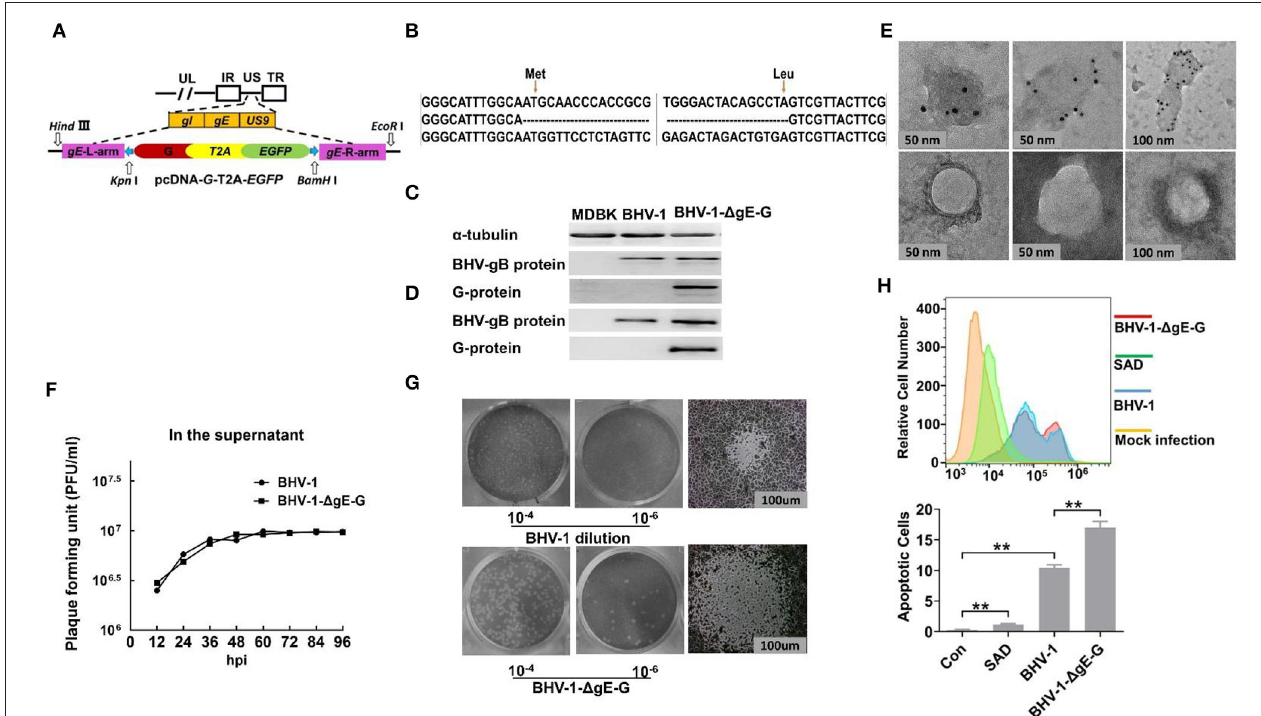
FIGURE 1 | Construction and characterization of BHV-1- 1 gE-G. (A) Schematic on the generation of a recombinant viral vector. The pcDNA3.1 expression vector is used as a backbone to construct the donor template. gE homologous arms were amplified using PCR from BHV-1 with the primer pairs L-ge and R-ge, the RABV G gene was amplified using PCR from SAD with primer pairs G-F and G-R, and the T2A and EGFP genes were amplified using PCR from pCAG-EGFP with primer pairs T2A-EGFP-F and T2A-EGFP-R. These PCR products were digested with enzyme sets HindIII & EcoR I, Kpn I & Not I, and Not I & BamH I, and then ligated into pcDNA3.1 plasmid vector (pcDNA-LgE-G-EGFP-RgE), respectively. (B) Viral genome DNA isolated from BHV-1- 1 gE-G infected MDBK cells was used to carry out PCR and sequencing. (C) The RABV G expressed in MDBK infected with BHV-1- 1 gE-G at 24 hpi was detected by Western blot. (D) The RABV G incorporated in virion of BHV-1- 1 gE-G was purified by sucrose gradient ultracentrifuge and detected by Western blot. (E) The RABV G incorporated in virion of BHV-1- 1 gE-G was purified by sucrose gradient ultracentrifuge and analyzed by EM. (F) Multistep growth curves of BHV-1- 1 gE-G and BHV-1 in MDBK cells. MDBK cells were infected with the indicated viruses at an MOI of 0.01, and the virus titers in infected cell supernatants were determined at indicated time point. (G) The plaque diameter of BHV-1- 1 gE-G and BHV-1 was analyzed by the viral plaque assay using a Nikon ECLIPSE TS100 microscope. (H) The prorogation of apoptotic cells infected by BHV-1- 1 gE-G, BHV-1, and RABV was determined with BD Accuri C6 Flow Cytometer, and the data were analyzed with FlowJo software (TreeStar, San Carlos, CA). Significance was assessed using Student’s t -test. ** P ≤